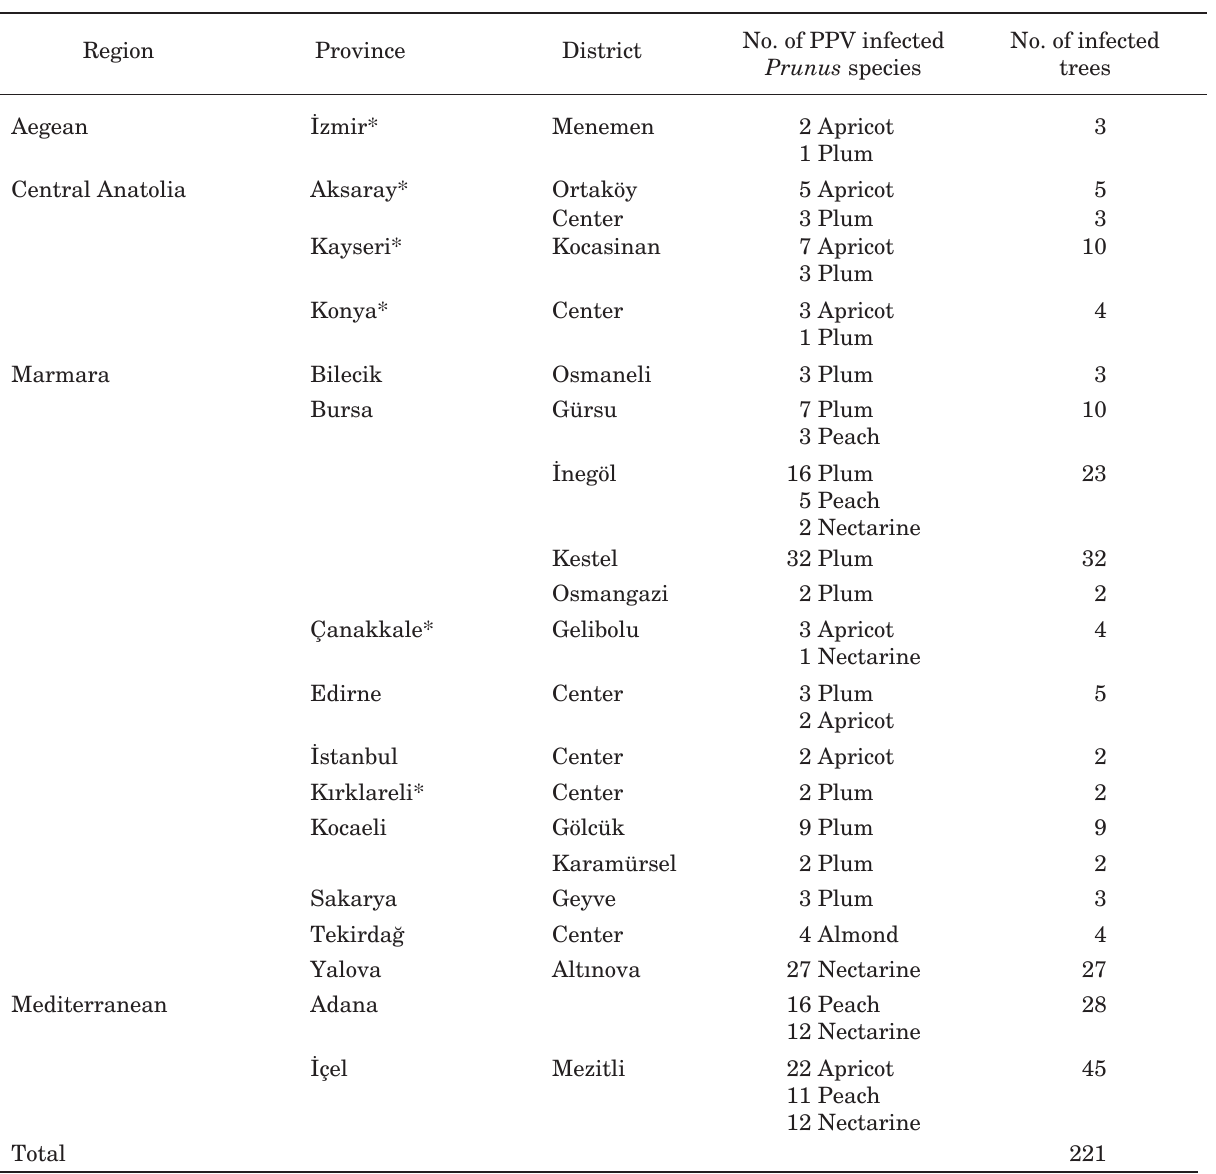
Table 3. ELISA test results of PPV ( Plum pox virus ) detection in Turkey (except Ankara province since this was too heavily infected).